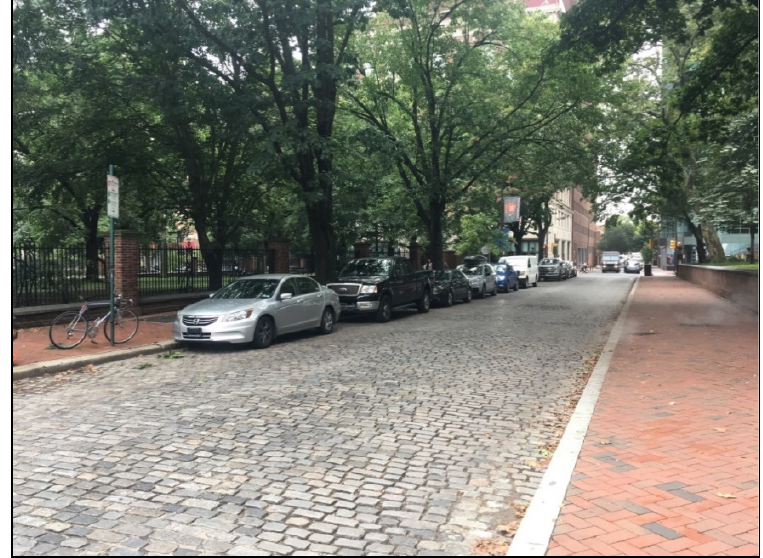
Figure 2. A Philadelphia street paved with granite block historic paving material, located at 102 S. Independence Mall E.